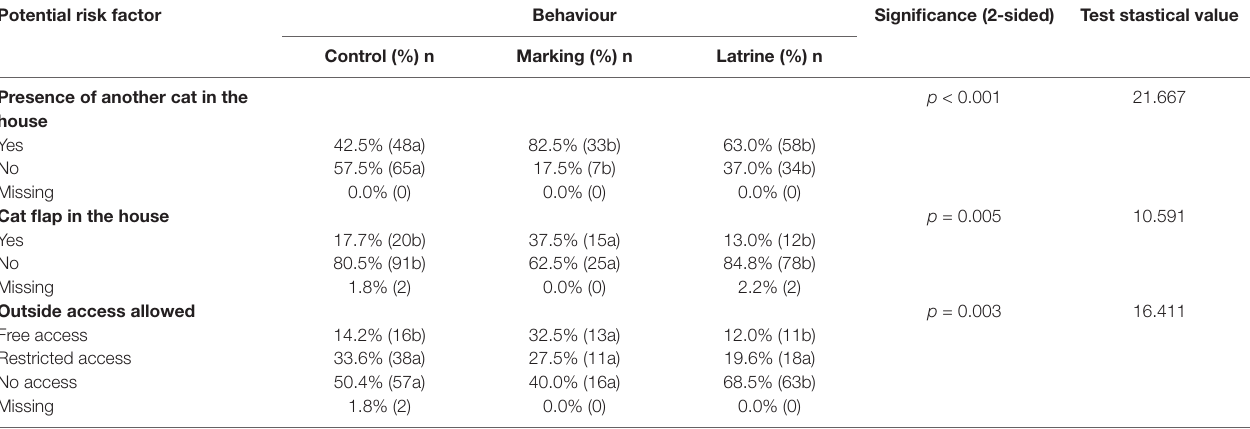
TaBle 4 | Significant potential household risk factors (Chi square test) for marking and latrine behaviour identified from the survey using univariate analysis.